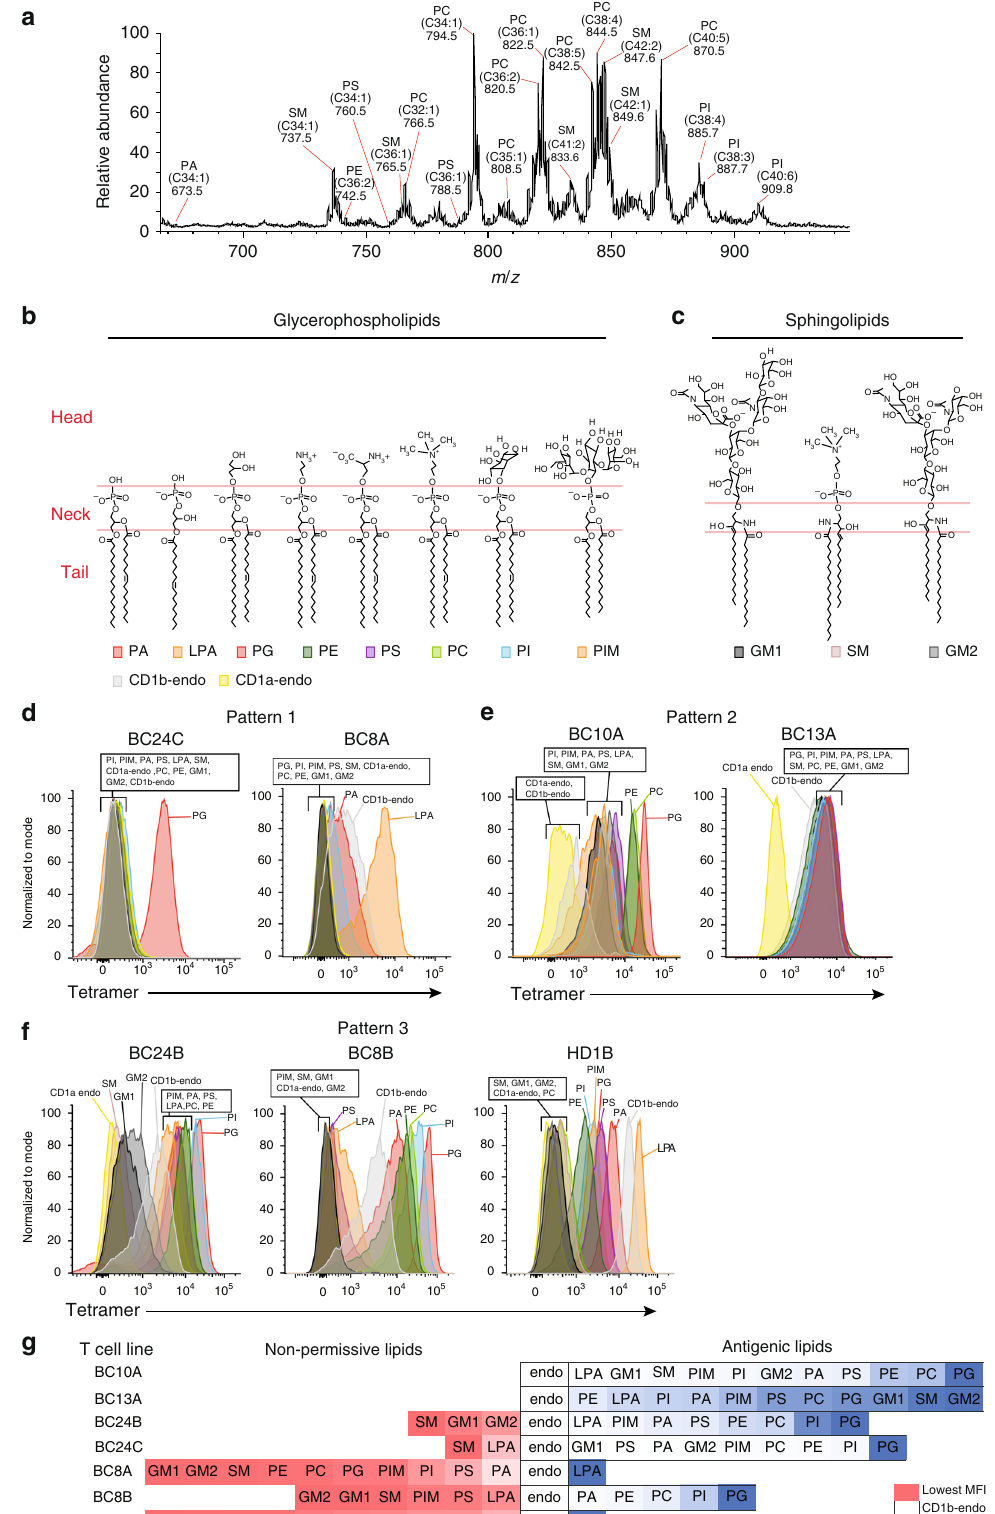
m / z 794.5, 808.5, 820.5, 822.5, 842.5 844.5) and sphingomyelin (SM, m / z 737.5 765.5, 849.6). For some ions, these tentative identi fi cations based on mass alone could not be formalized due to limited MS intensity or mass accuracy (Fig. 2a). However, for all six lipid classes, CID mass spectrometry identi fi ed